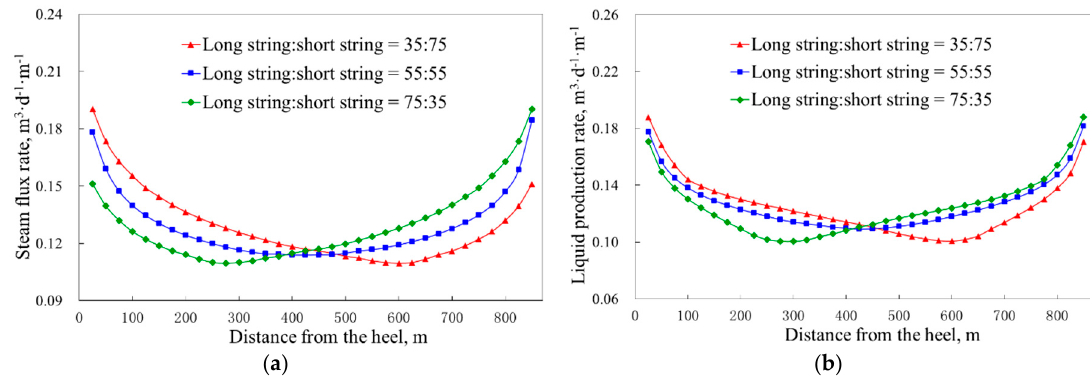
Figure 13. Effect of the steam injection ratio on the injection and production profiles: ( a ) steam flux rate; ( b ) liquid production rate.